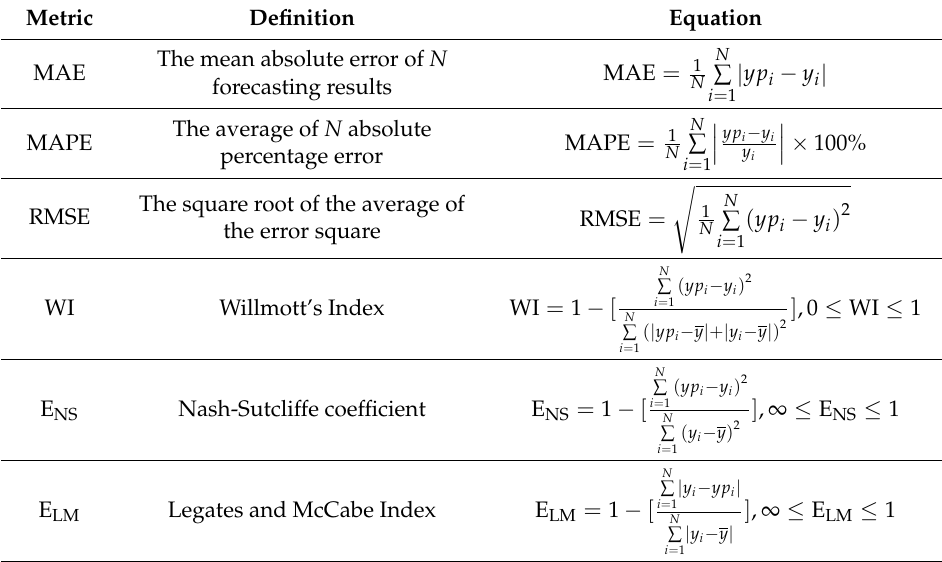
Table 1. The description of the error evaluation